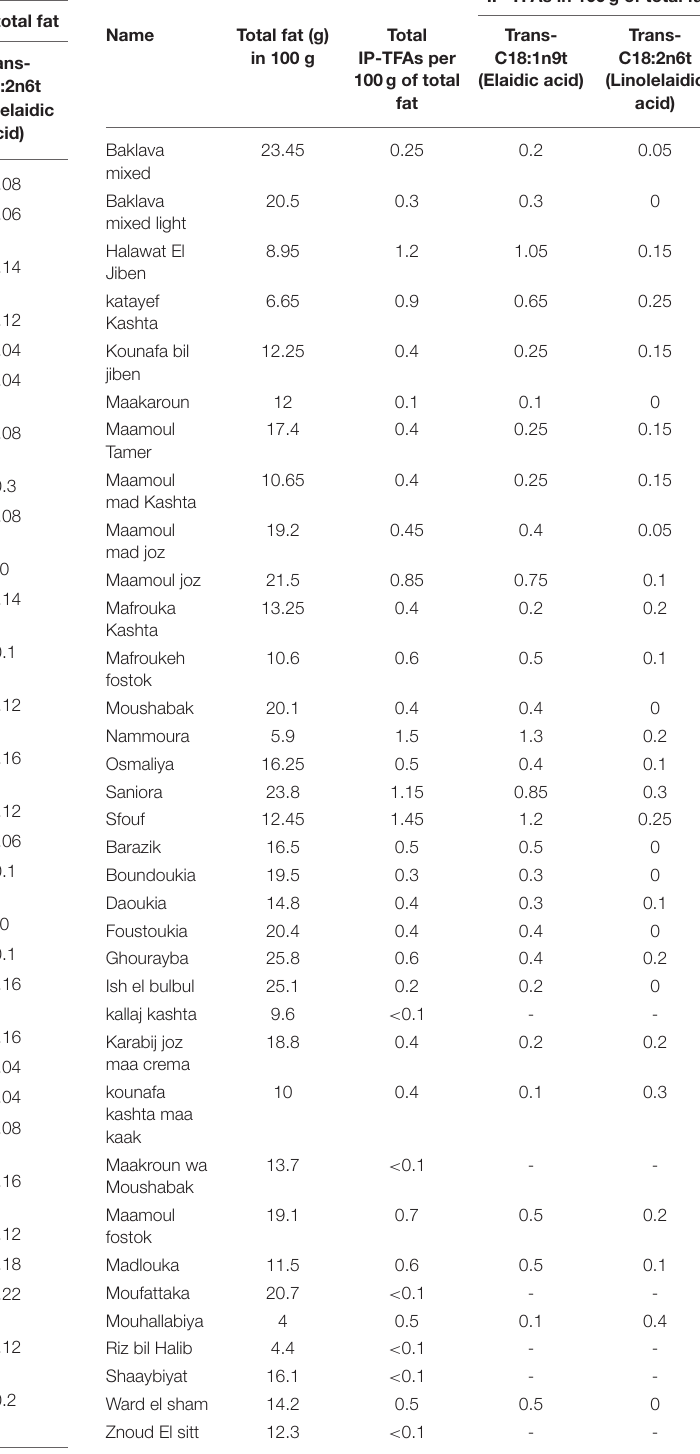
TABLE 1 | Mean levels of total fat in 100g of edible portions, total IP-TFAs, and IP-TFAs (EA and LEA) in 100g of fat of frequently consumed traditional dishes among all Lebanese governorates.